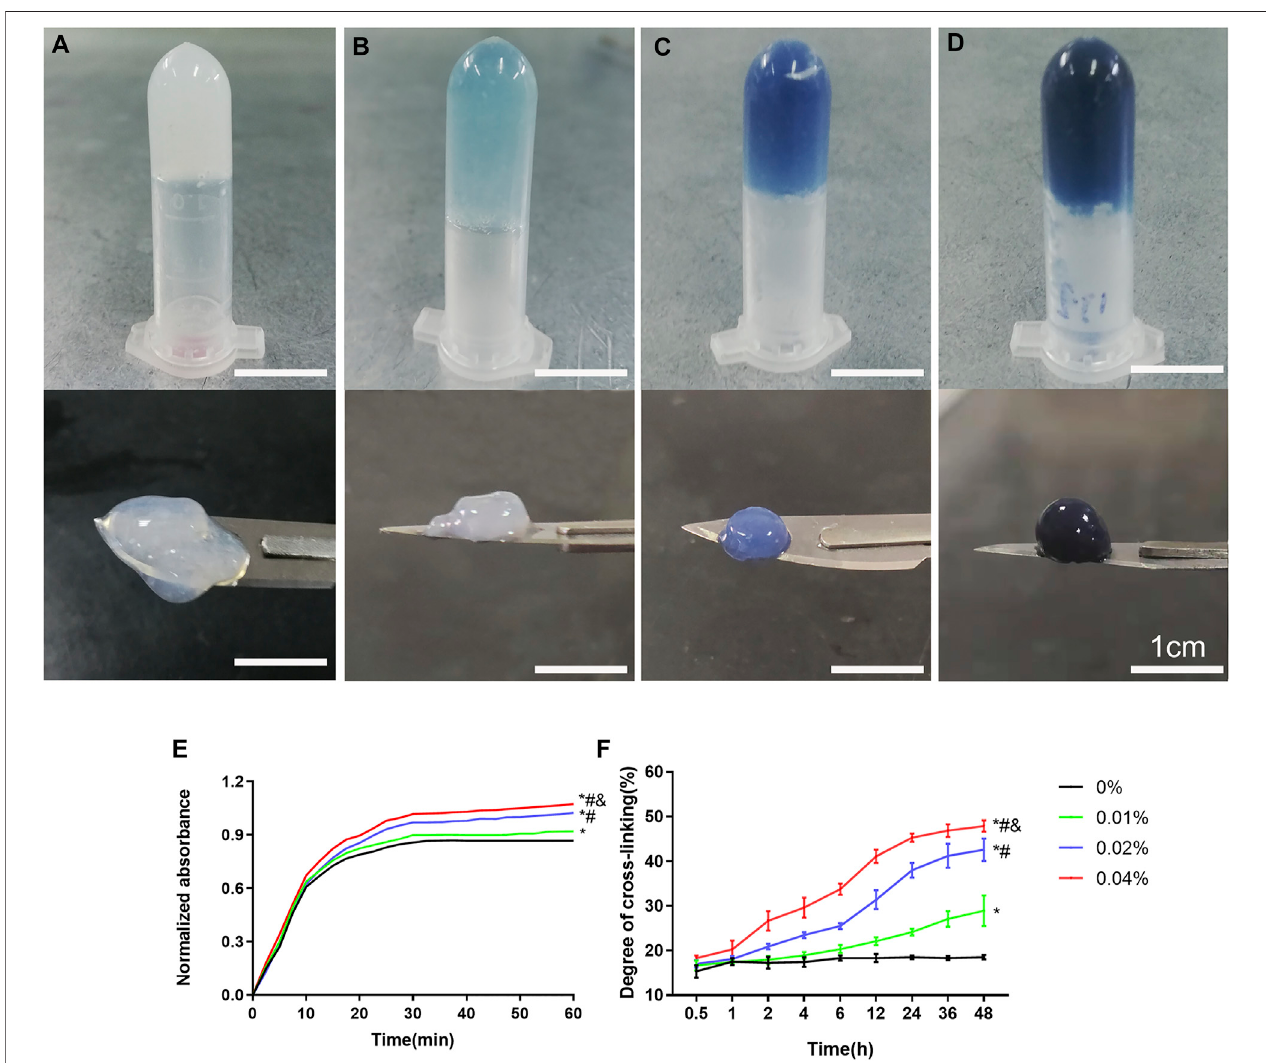
FIGURE 1 | The appearance and cross-linking degree of the GDH cross-linked by different concentrations of genipin for 48 h. The morphology and color of GDH shown in the 0% (A) , 0.01% (B) , 0.02% (C), and 0.04% (D) groups. (E) : Gelation kinetics curve; (F) : time-variant degree of cross-linking measured by the ninhydrin experiment. Data represented mean ± SD ( n (cid:2) 5); * p < 0.05, vs. 0% group; # p < 0.05, vs. 0.1% group; & p < 0.05, vs. 0.02% group. Scale bar (cid:2) 1